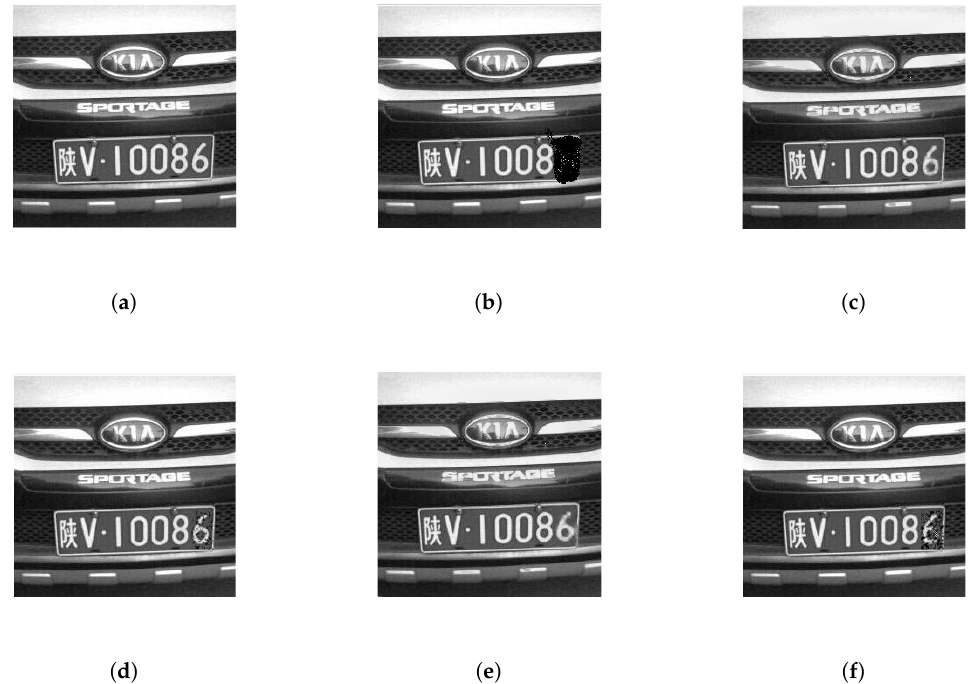
Figure 9. Restoration results of different algorithms under specific local data missing only. ( a ) original image (online image); ( b ) corrupted image with specific local missing; ( c ) reconstructed image obtained by framelet+APG; ( d ) reconstructed image obtained by framelet+ADMM; ( e ) reconstructed image obtained by wavelet+APG; ( f ) reconstructed image obtained by